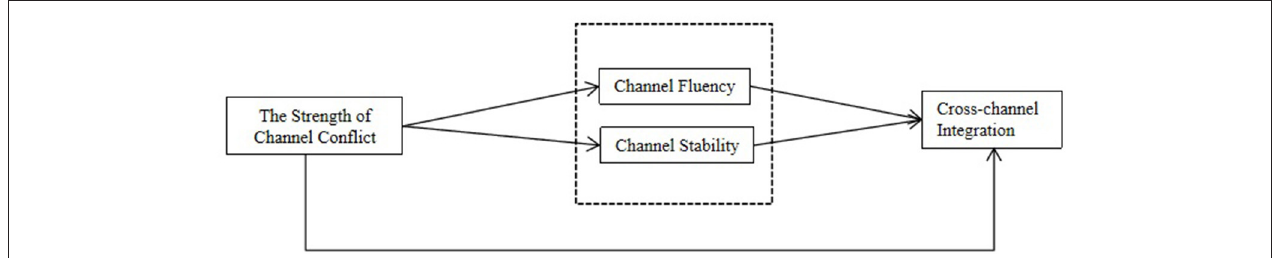
FIGURE 1 | Conceptual model of the impact of the strength of channel conflict on cross-channel integration.